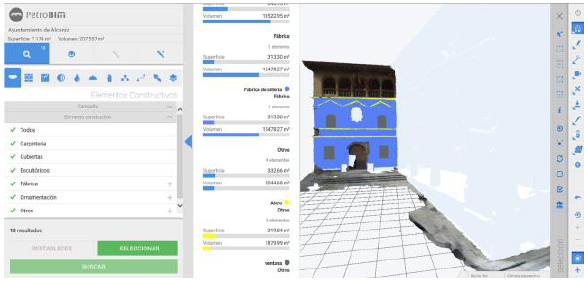
Figure 6. Web platform Petrobim. Results of the search for constructive